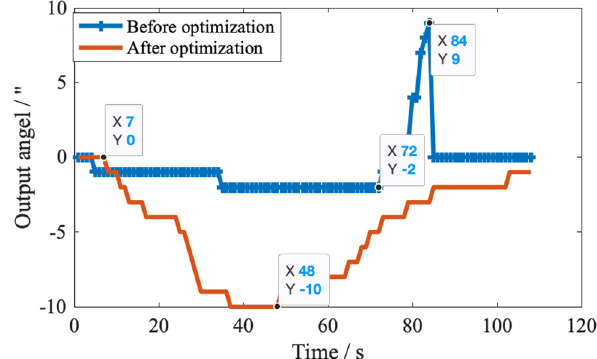
Figure 12: HD test prototype.